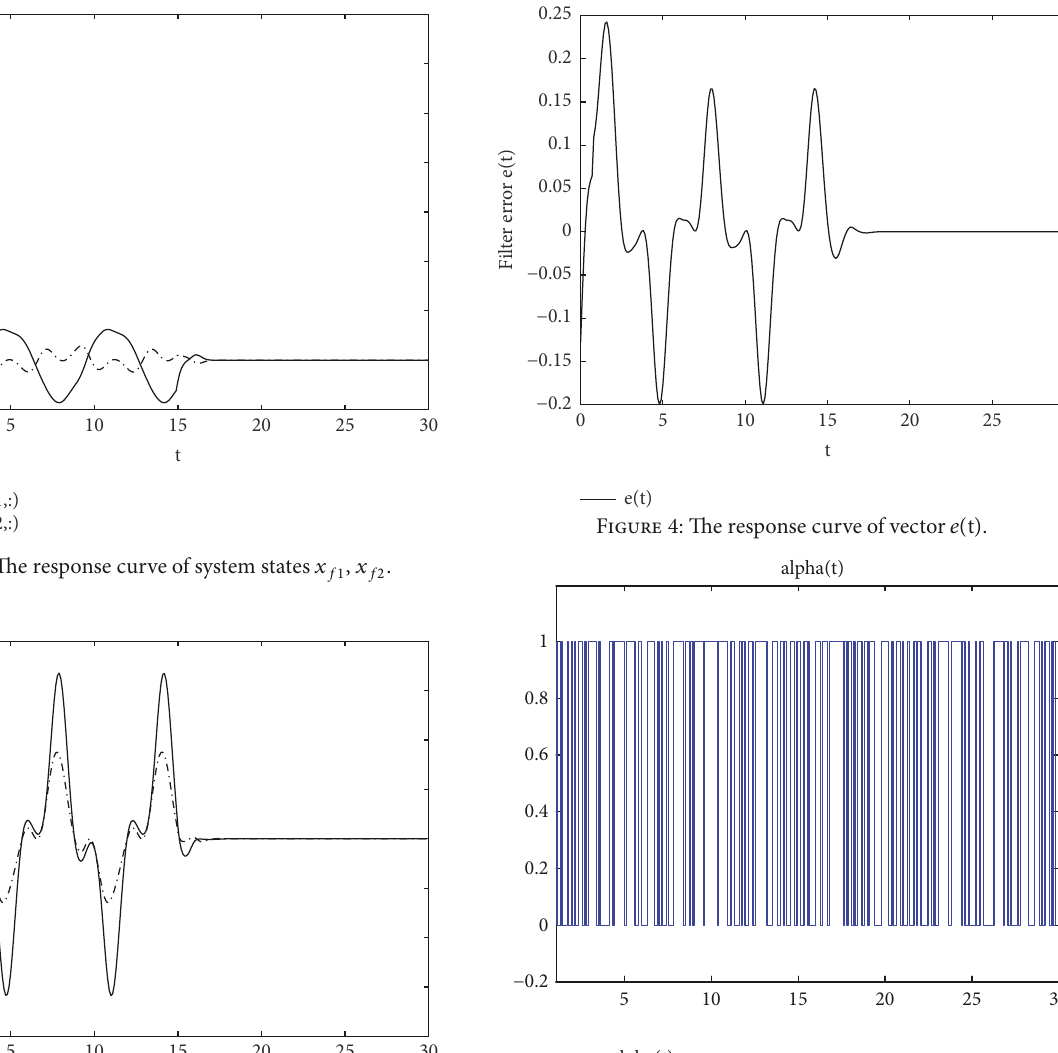
Figure 5: The event occurrence probability 𝛼( t ) .